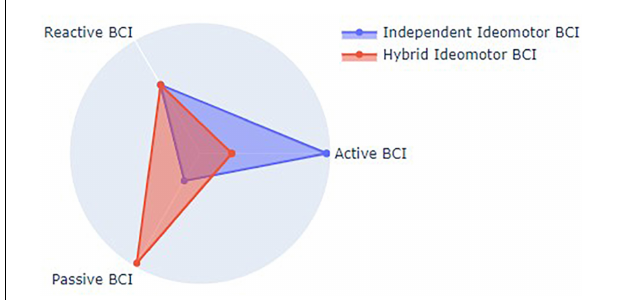
FIGURE 3 | Theoretical positioning of Ideomotor BCI types relative to existing BCI